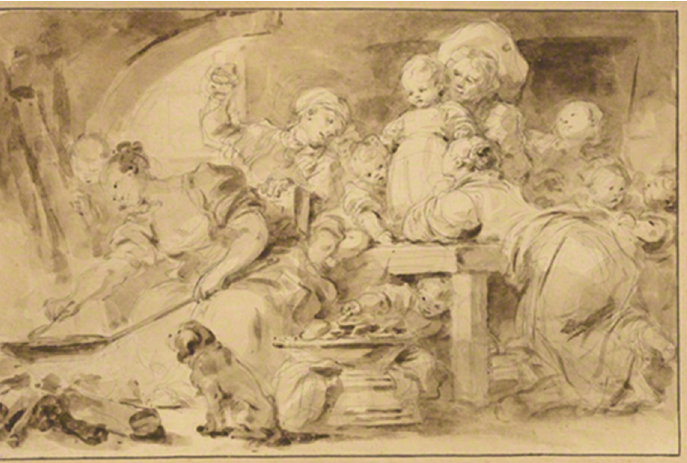
Figure 2. Jean-Honoré Fragonard (French, 1732–1806), Making Fritters (Les Beignets), approximately 1782, Brush and brown ink over graphite, 24.6 cm × 37.5 cm (9 11/16 × 14 3/4 in.), 2012.4, The J. Paul Getty Museum, Los Angeles.